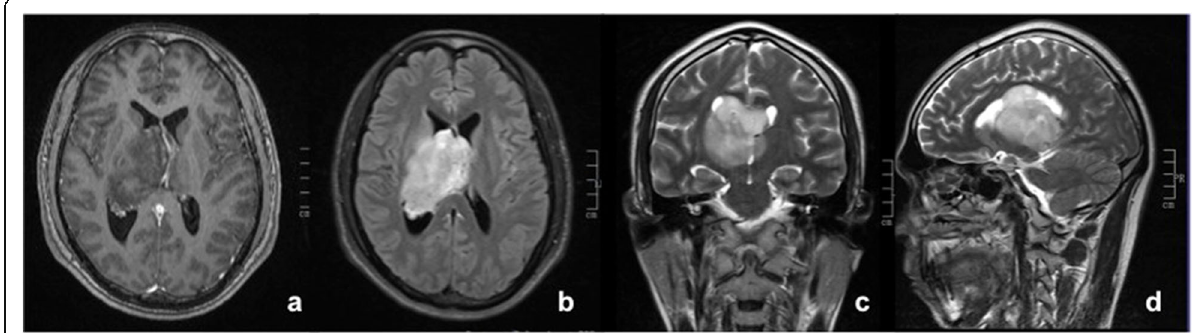
Fig. 1 MRI brain (contrast) showed a large, fairly defined lobulated heterogeneously enhancing space occupying lesion with its epicenter in subependymal region of right lateral ventricular body, showing gross extensions into the intraventricular space, thalamus, body of corpus callosum, and leftward displacement of septum pellucidum, with mild ventricular dilatation. There was a small eccentric non-enhancing cystic necrotic focus. A small focus, hypointense on T1 and hyperintense on T2 and FLAIR sequences with restricted diffusion on diffusion-weighted imaging (DWI) and heterogeneous post-contrast enhancement was seen involving left thalamus. No leptomeningeal enhancement was seen. a Axial T1 contrast sequence. b – d Axial, coronal, and sagittal T2 FLAIR sequences of the brain showing the tumor